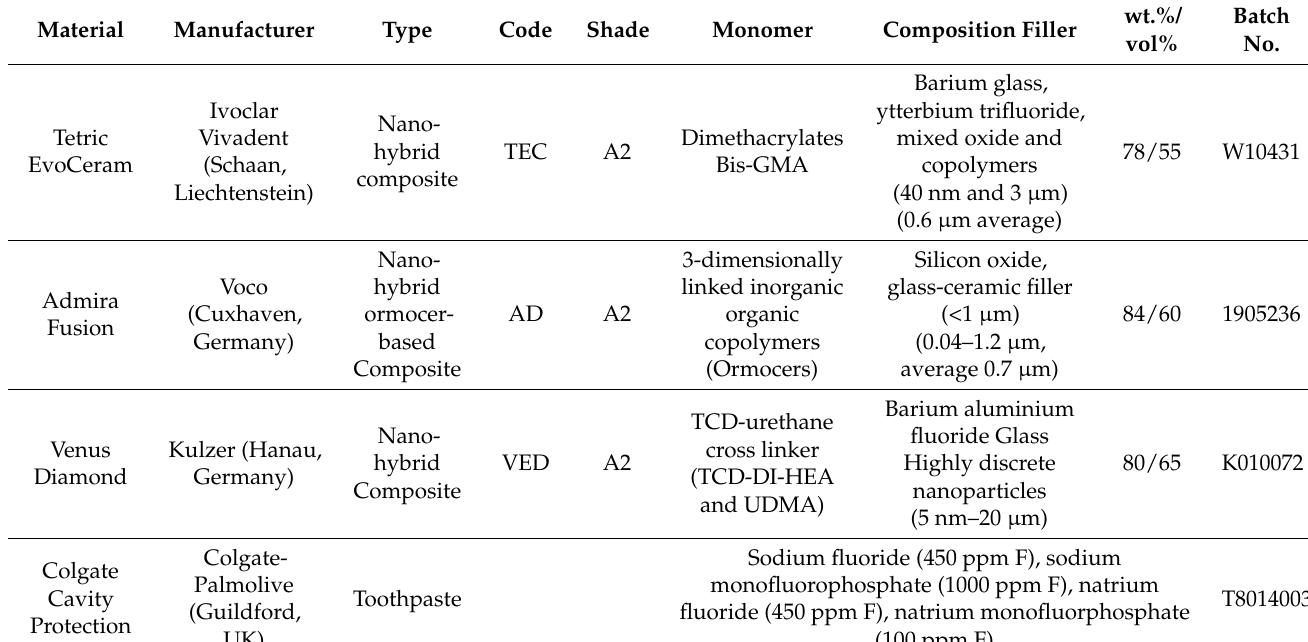
Table 1. List of the materials used in this